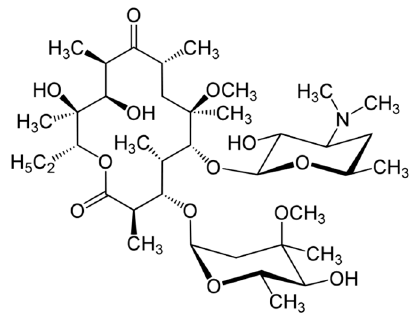
Figure 1. Chemical structure of clarithromycin (CLR).